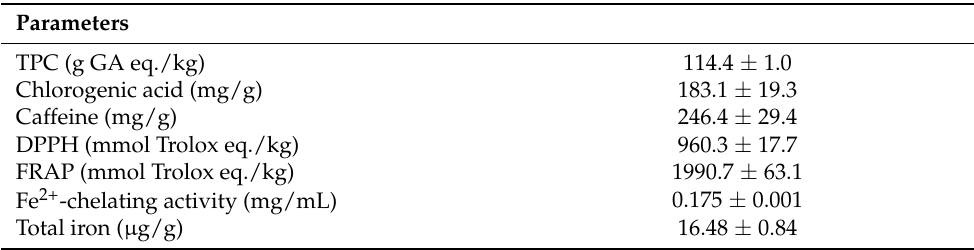
Table 1. Total phenolic content (TPC), chlorogenic acid, and caffeine concentration, antioxidant capacities (DPPH and FRAP), Fe 2+ -chelating activity, and total iron of the dGCB extract. The values are expressed as the mean ± standard deviation of three